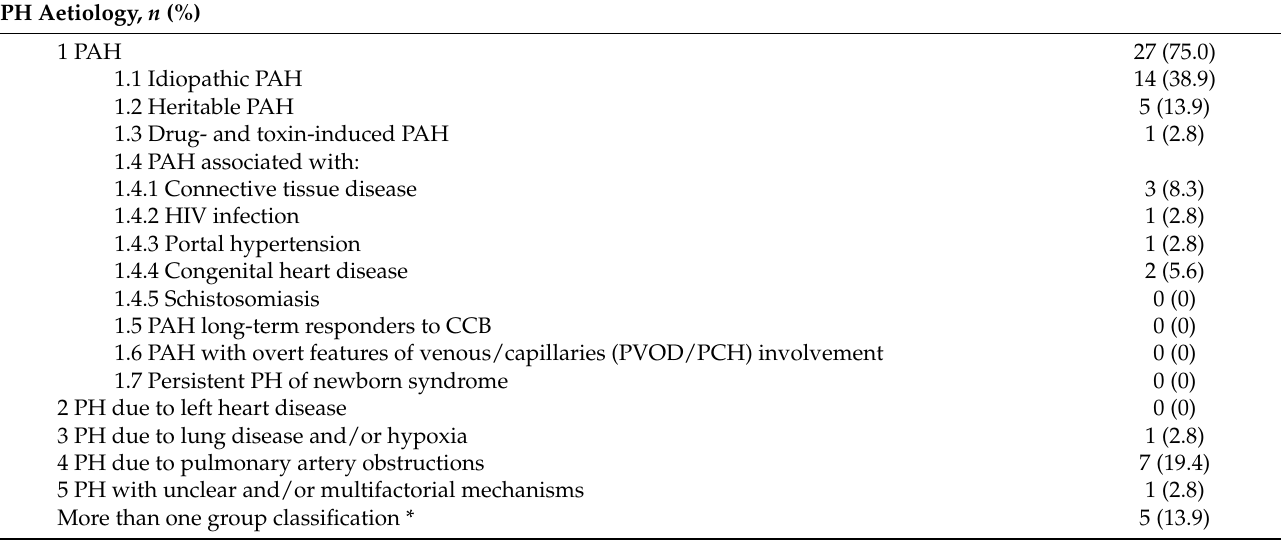
Table 2. Classification of PH etiology in the study population ( n =